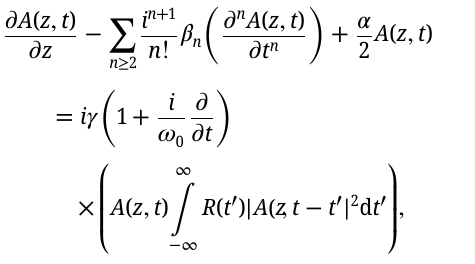
Figure 2: Group velocity dispersion ( 𝛽 ) for the TE fundamental mode of 2 a standard silicon nitride waveguide with width × height cross-section 1.7 μ m × 0.87 μ m and the TM fundamental mode of 1.0 μ m × 2.09 μ m and 1.15 μ m × 2.17 μ m waveguides with dimension. The material GVD of SiN (in its stoichiometric form) is shown as a dashed line. The insets